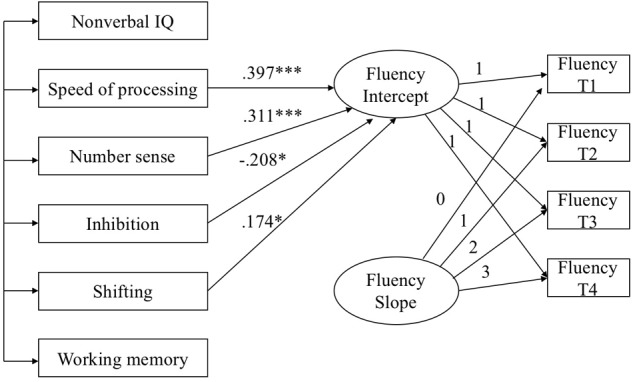
Predicting the intercept and slope in arithmetic fluency. Model Fit: χ2 = 16.63, df = 17, p = 0.48, CFI = 1.000, TLI = 1.002, RMSEA = 0.000, ∗p < 0.05, ∗∗∗p < 0.01.